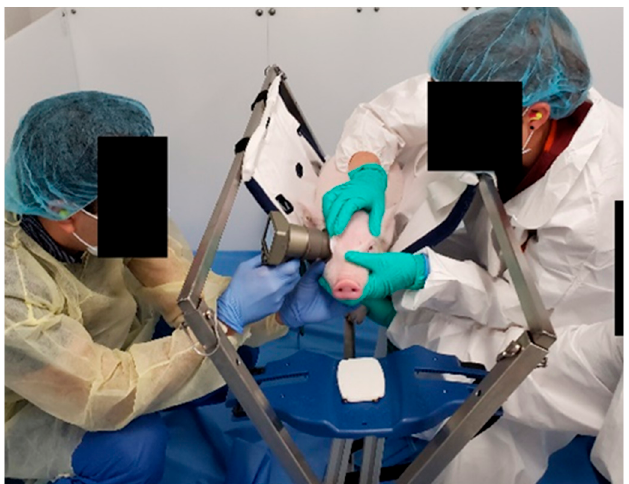
Figure 2. The experimental setup used in this study showing the position of the piglets in the sling and placement of the pupillometer on the animal’s eye.